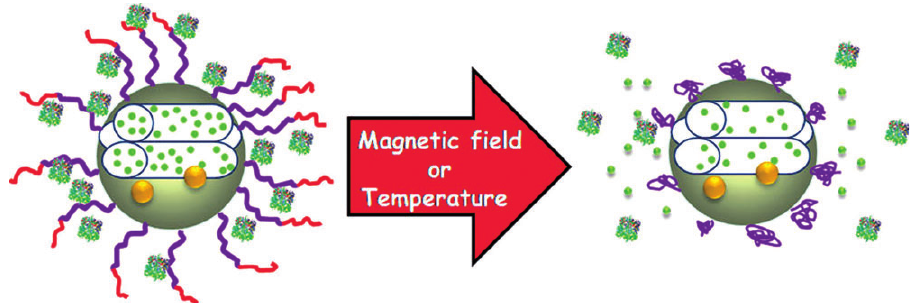
Figure 13 Schematic illustration of magnetically or heat-triggered drug release (green dots) from MNP (yellow particle)-loaded nanocompos- ites with collapse of polymer (purple chains) [82] . Reprinted with permission from Ref. [82] . Copyright (2012) American Chemical Society.